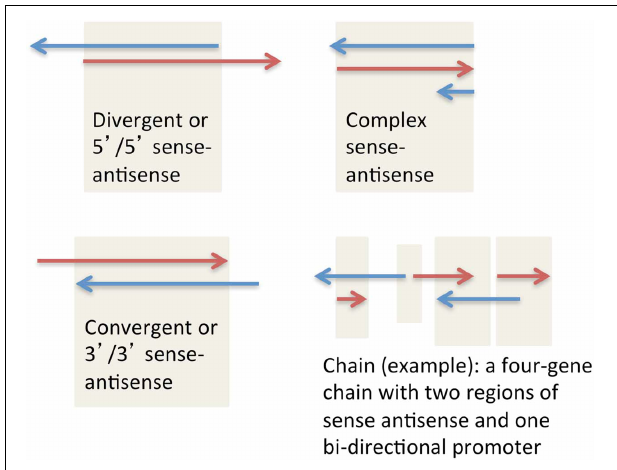
FIGURE 1 | Three major types of sense-antisense pairs, and one possible type of a gene chain.